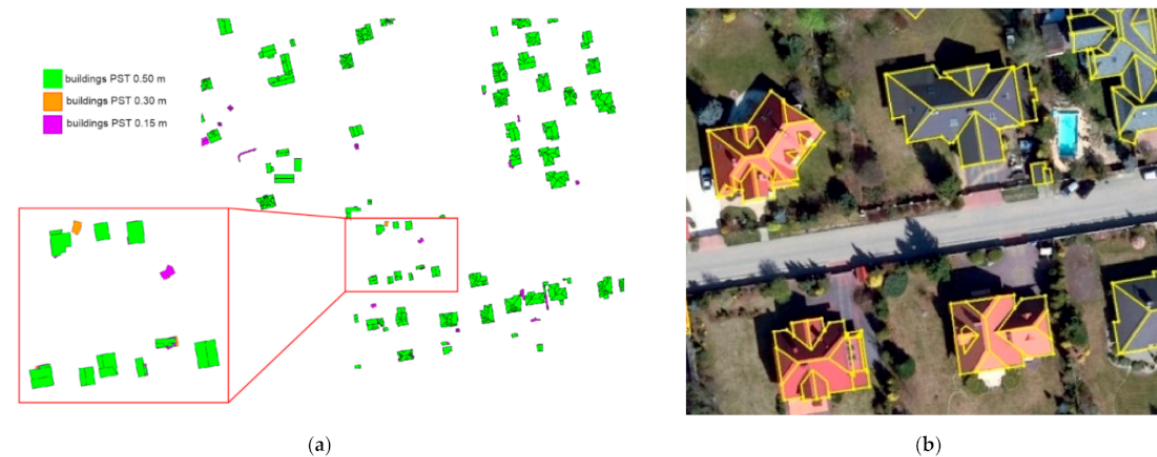
Figure 5. LiDAR rooftop polygons: ( a ) adjustment of the Plane Surface Tolerance values, ( b ) selected examples of building rooftop outlines (yellow lines) superimposed on aerial